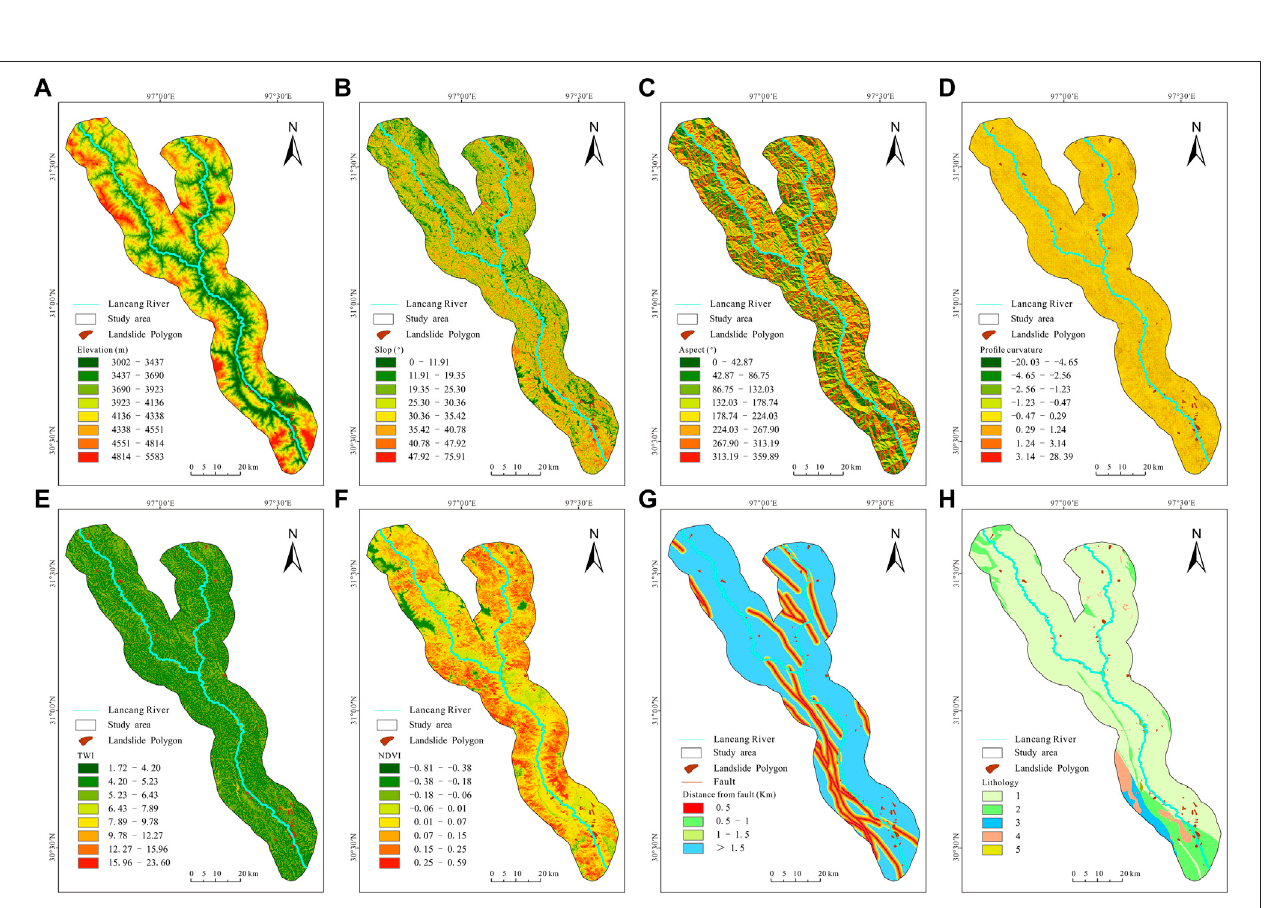
FIGURE3| Landslideconditioningfactors: (A) elevation, (B) slope, (C) aspect, (D) pro fi lecurvature, (E) TWI, (F) NDVI, (G) distancefromafault, (H) lithology.Note: for the legends in (H) , “ 1 ” represents the conglomerate, sandstone, and mudstone with bedding developing; “ 2 ” represents limestone, slate, dolomite, and marble; “ 3 ” represents gneiss, granulite, and quartz schist; “ 4 ” represents blocky granite, diorite, and magmatic dike, and “ 5 ” represents loose gravel, sand, and detritus soil.